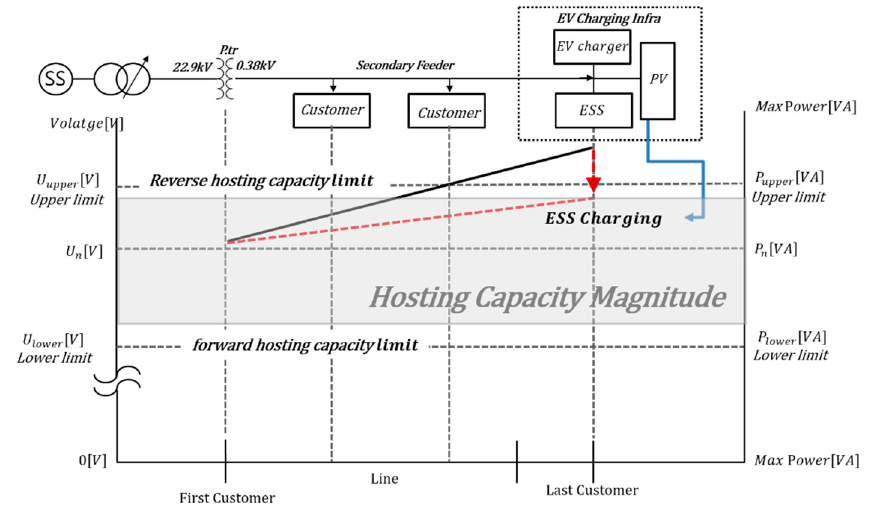
Figure 3. Operation strategy of VPL ESS in case of upper limit.